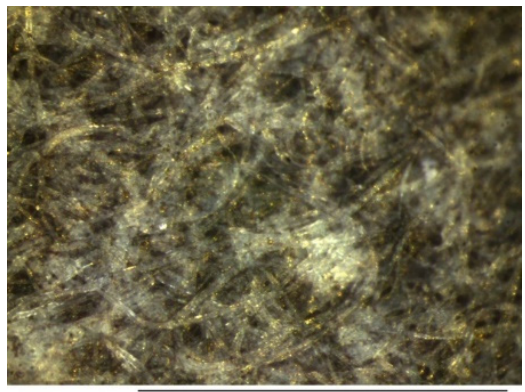
Figure 7. Gold nanoparticles after precipitation with sodium borohydride of the gold(III)-thiocyanate solution.